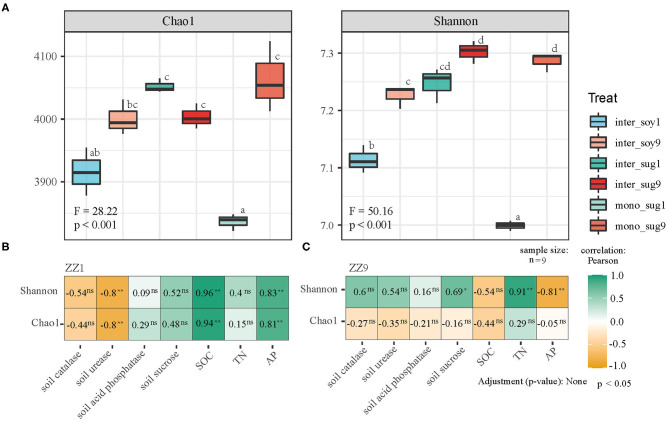
(A) Bacterial alpha-diversity measurements of represented by Chao 1 and Shannon indexes in each pattern. F, Fisher's F-ratio; p, p-value. Different letters next to the bars represent significant differences between the measured indices. (B,C) The correlation between bacterial alpha-diversity and environmental factors using Pearson analysis. P > 0.05 (NS), *P < 0.05, **P < 0.01.